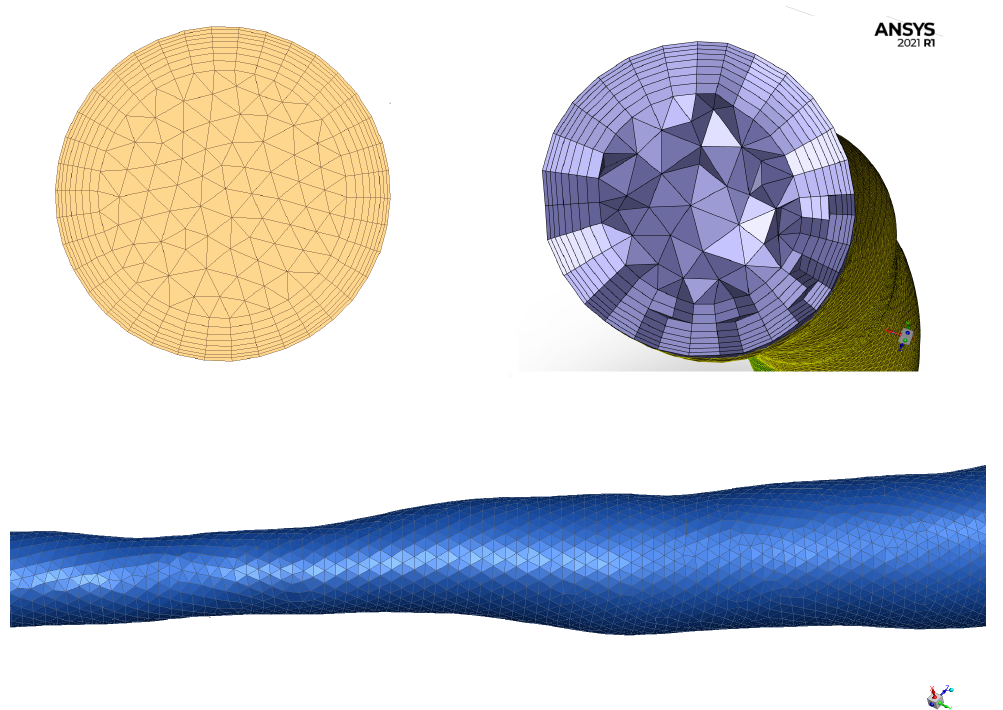
Figure 4. Example of mesh generated from a 3D reconstruction of case LCX 0102_4060. Top left corner : inlet face, top right : cross-section in stenosed region, and bottom : outside wall.